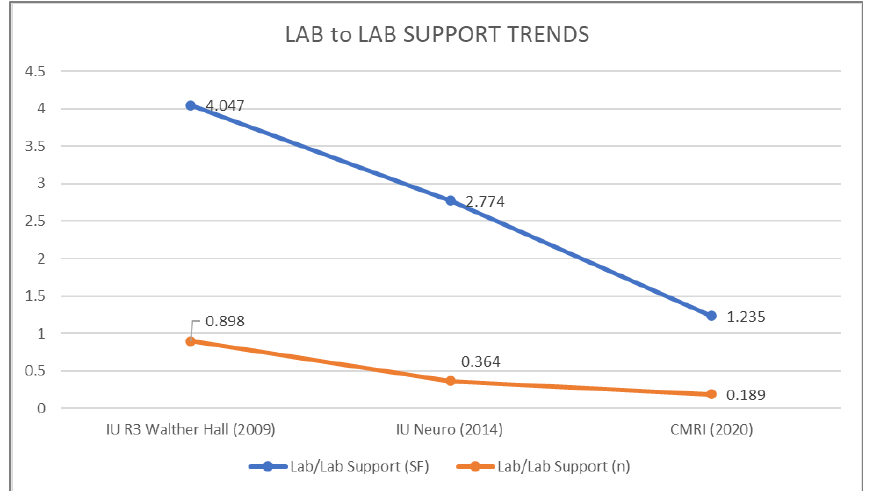
Figure 7 The ratio of lab-to-lab support decreased over